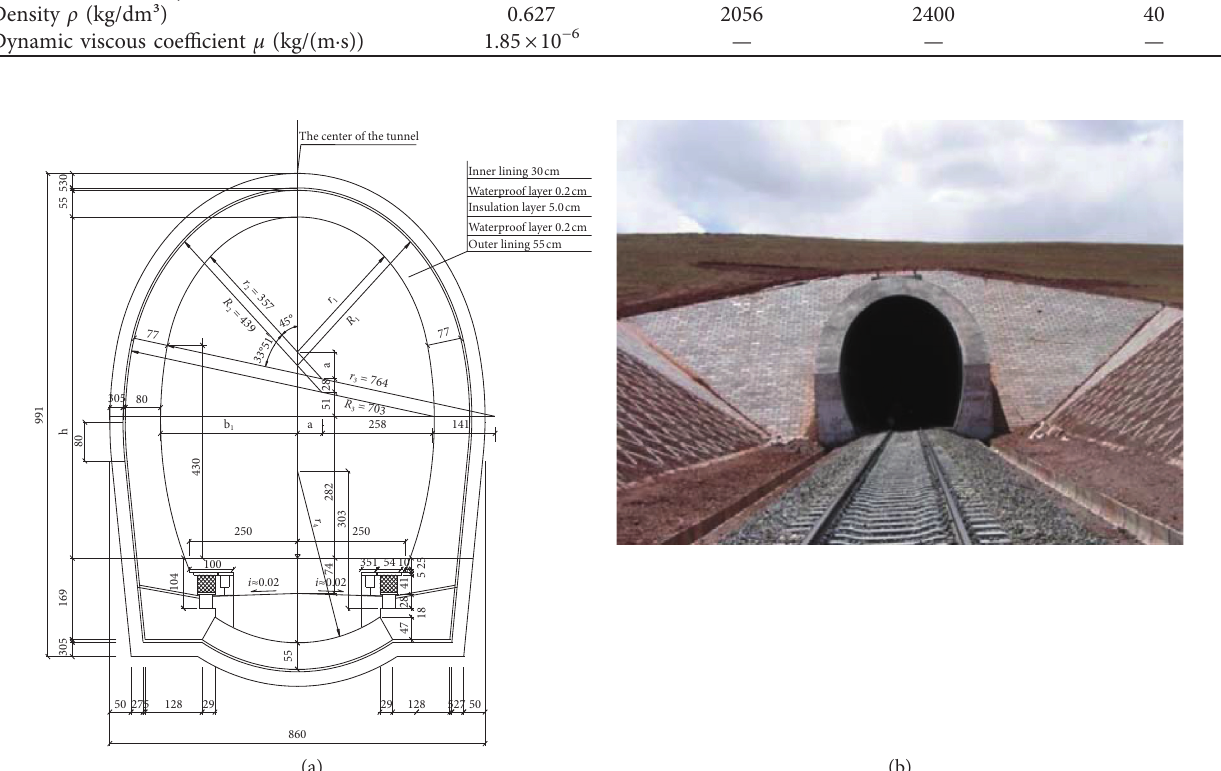
Figure 10: Cross-sectional geometry of the Fenghuo Tunnel: (a) cross-sectional structure of the schedule drawing; (b) practical engineering of the Fenghuo Tunnel.